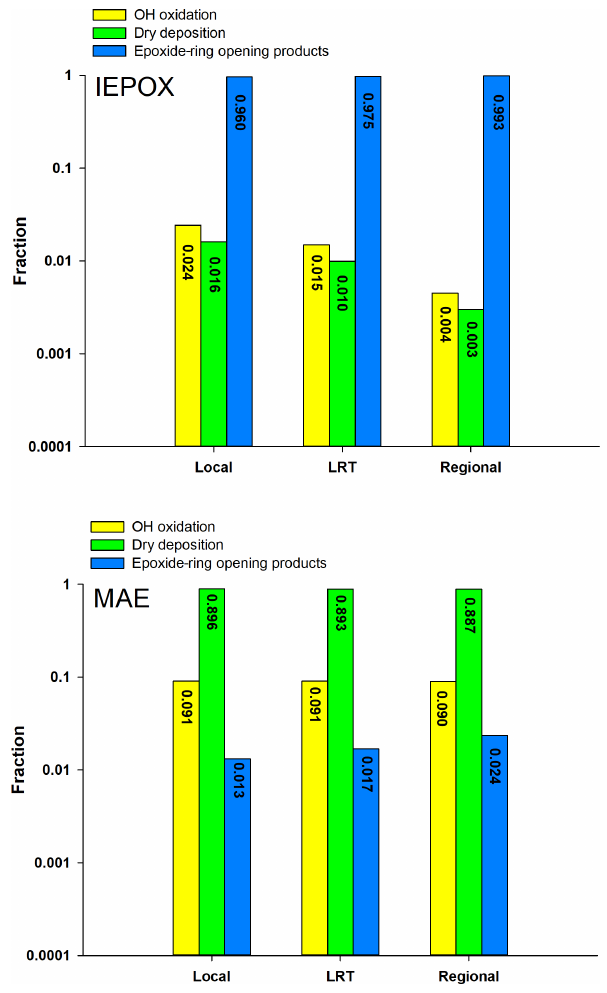
Figure 1. Comparison of three degradation processes for IEPOX and MAE under the three synoptic